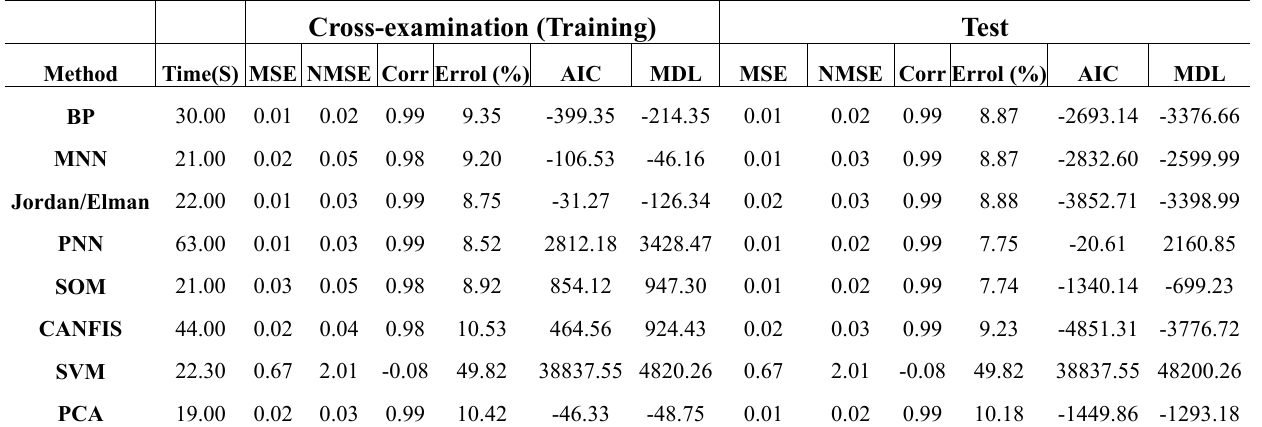
Table 5. The evaluation result of the eight cloud classifiers for the training and testing data.